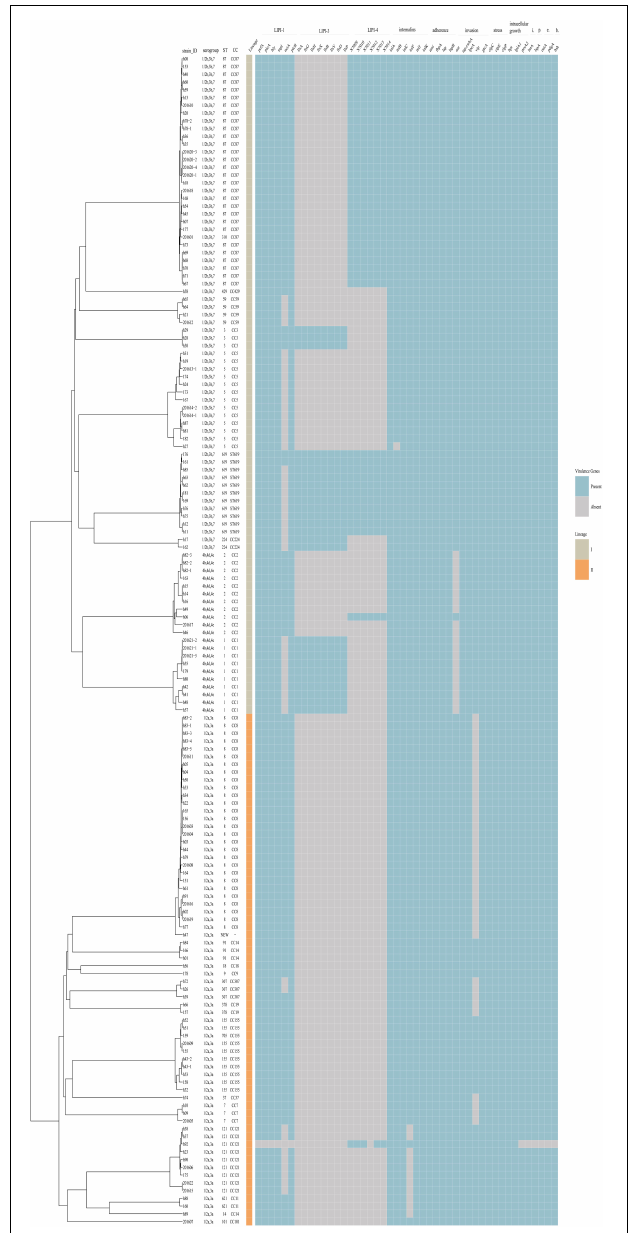
FIGURE 4 | Virulence profiles across the phylogeny of the 151 L. monocytogenes isolates. The presence/absence gene matrix represents, from left to right, genes located in the pathogenicity islands LIPI-1 ( prfA, plcA, hly, mpl, actA, plcB ), LIPI-3 ( llsAGHXBYDP ) and LIPI-4 (LM9005581_70009 to LM9005581_70014), genes coding for internalins ( inlABCFGK ) and other genes involved in adherence ( ami, fbpA, lap, lapB ), invasion ( aut, cwhA, lpeA, vip, gtcA ), stress ( clpC, clpE, clpP ), intracellular growth ( hpt, lplA1, prsA2 ), immunomodulator ( lntA ), peptidase ( lspA ), immune evasion ( oatA, pdgA ) and bile-resistance ( bsh